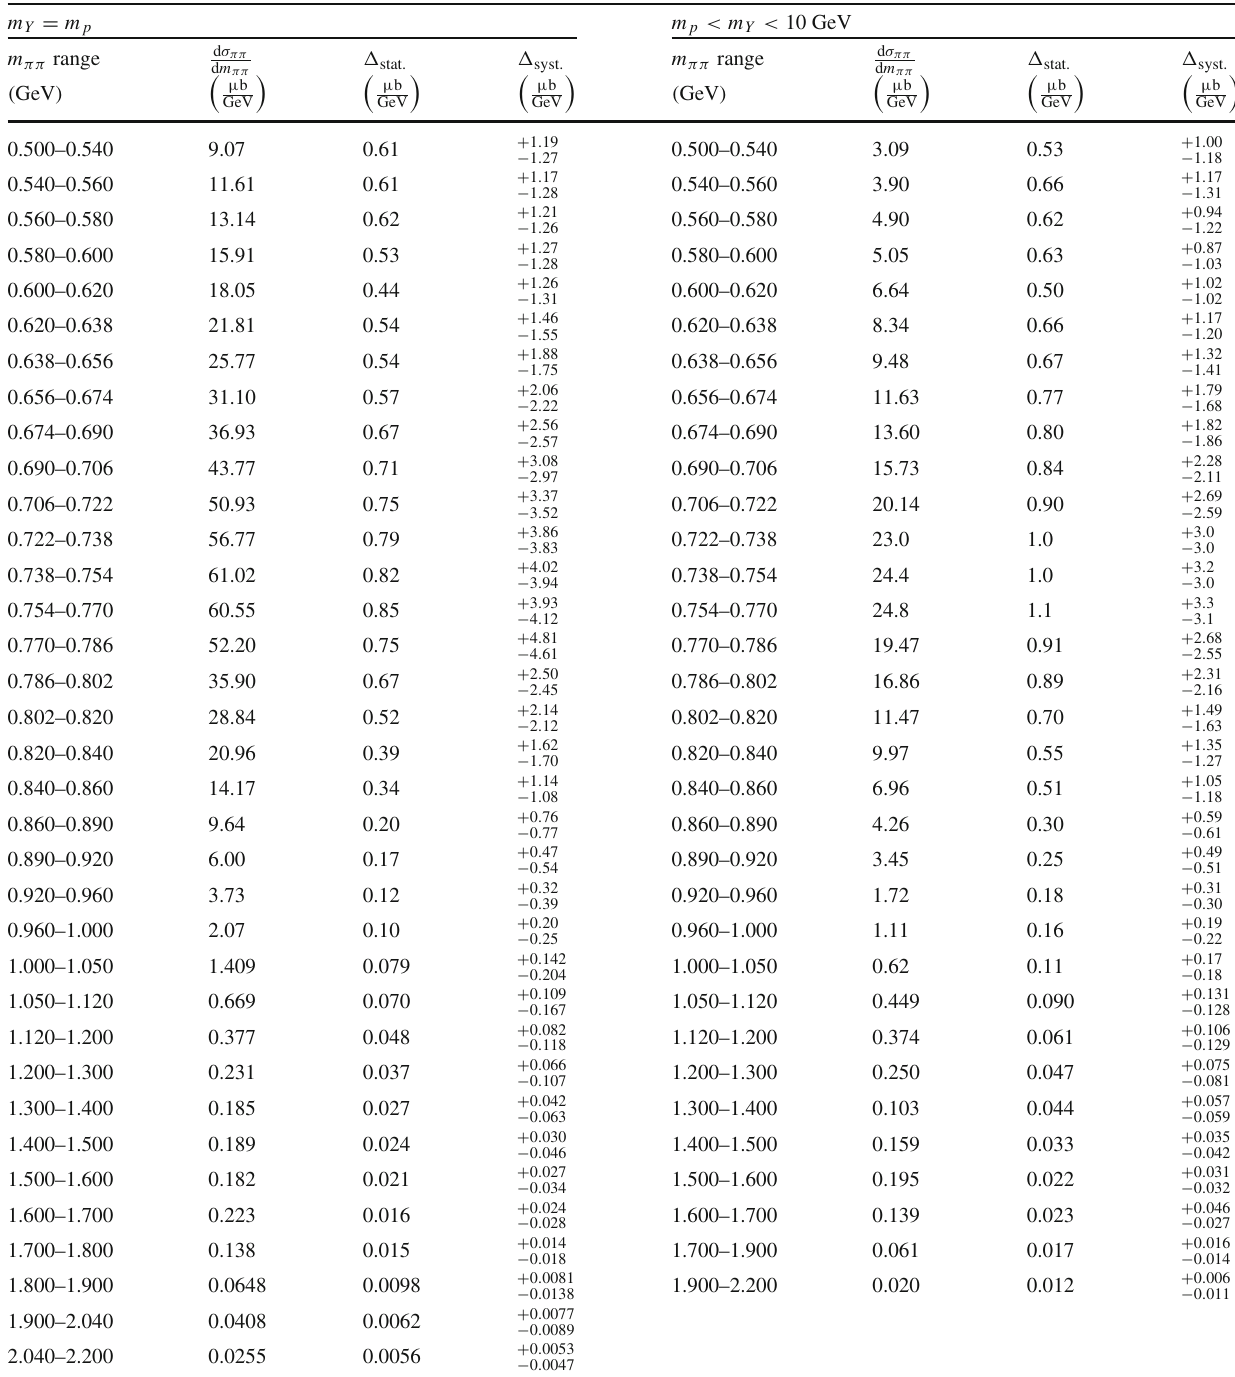
Table 17 Unfolded elastic ( m Y = m p ) and proton-dissociative ( m p < m Y < 10 GeV) differential π + π − photoproduction cross sections measured in the fiducial phasespace defined in Table 3 and calculated